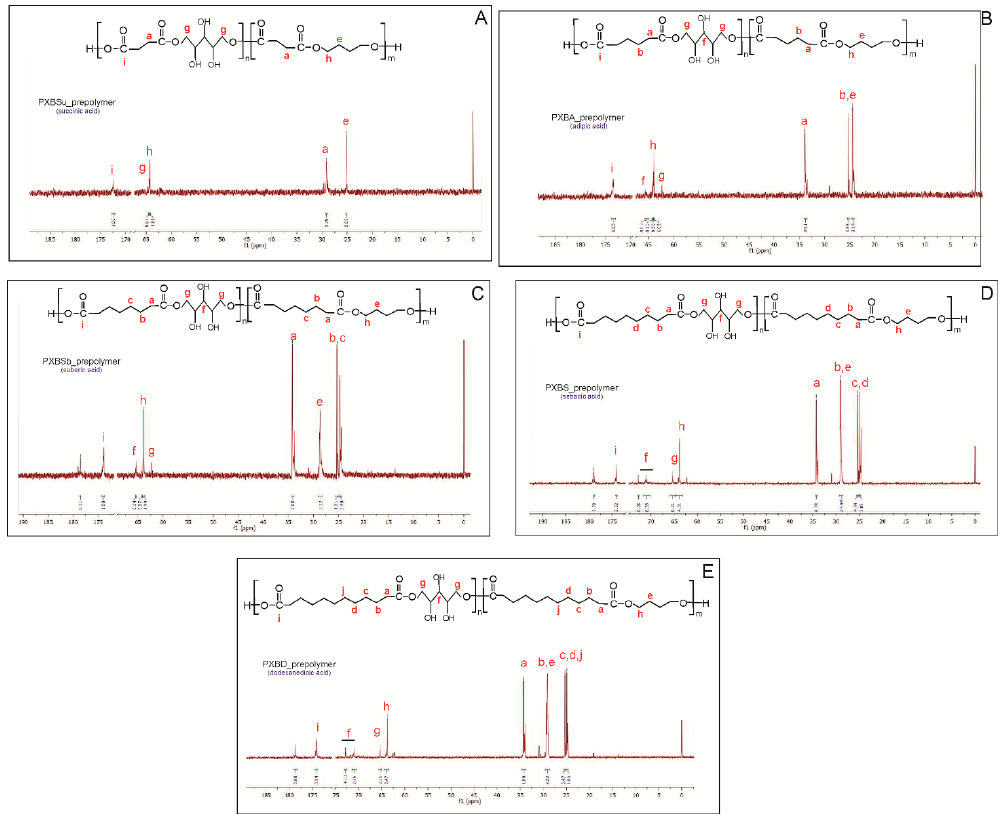
Figure 3. 13 C NMR of PXBSu( A ), PXBA( B ), PXBSb( C ), PXBS( D ), PXBD( E ) prepolymers.